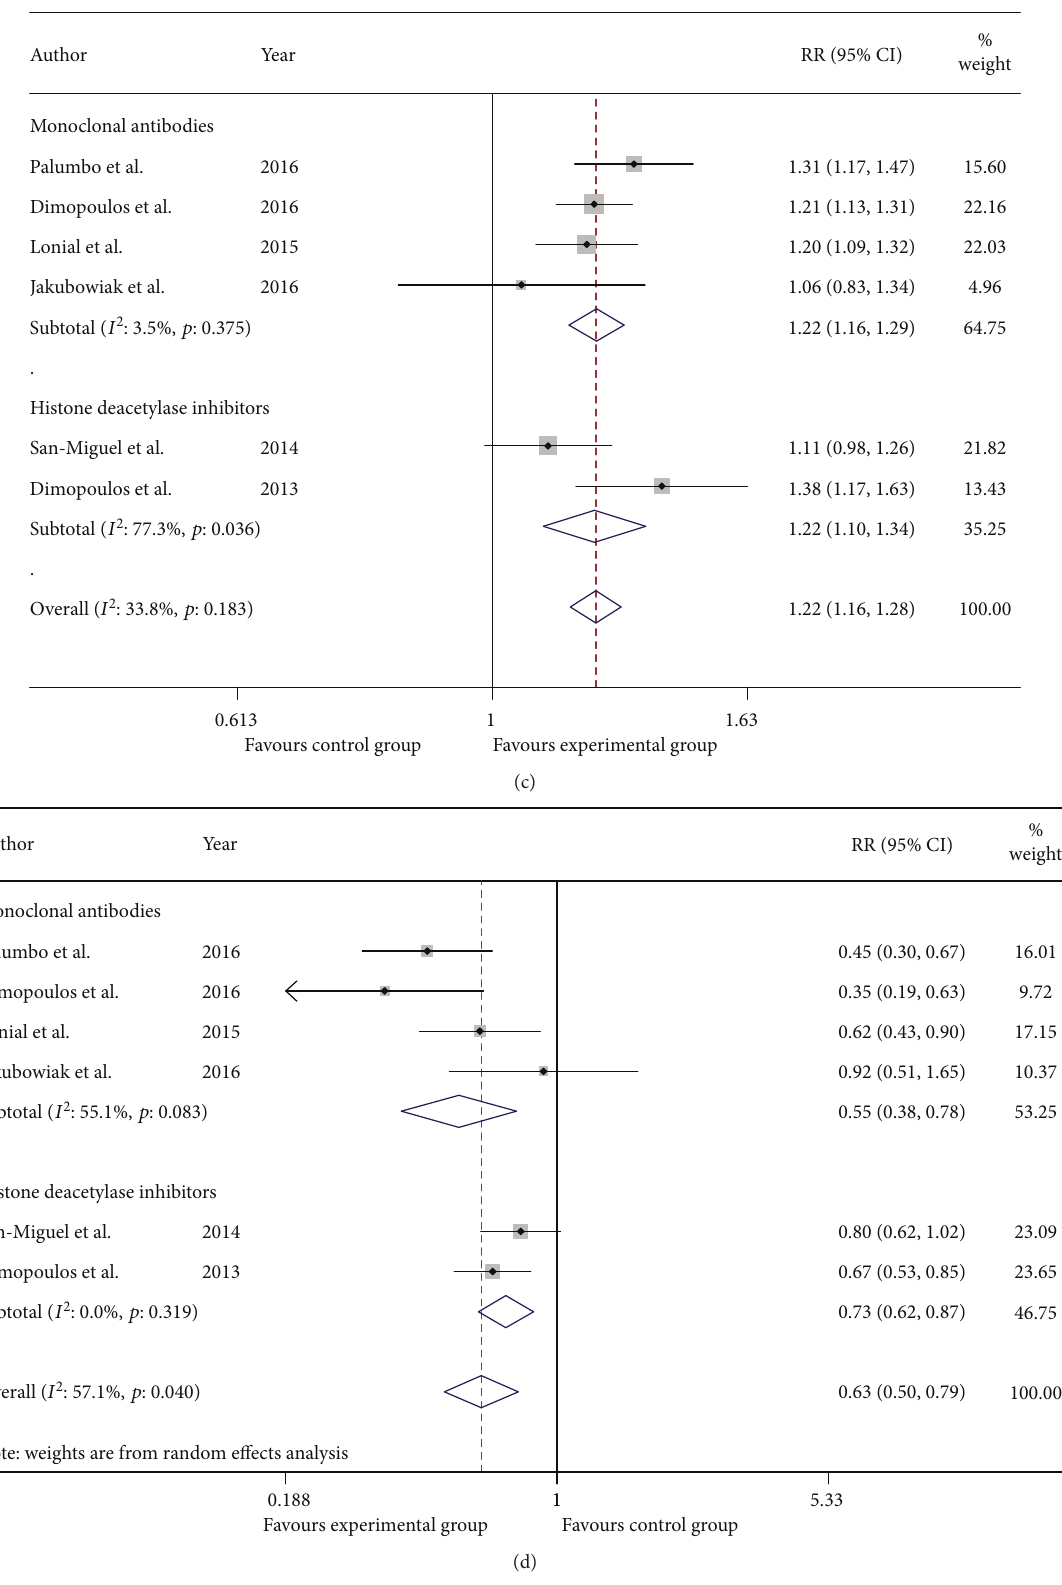
Figure 3: Meta-analysis of the e ffi cacy of MAbs group and HDACi group in patients with RRMM: risk ratio for complete response (a), very good partial response (b), overall response (c), and progressive disease plus stable disease (d) of MAb group and HDACi group versus their corresponding control